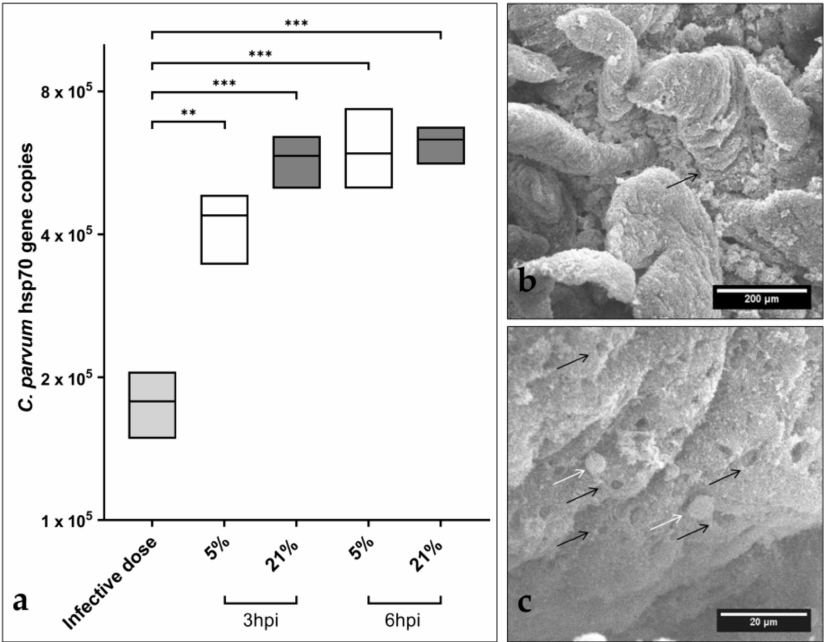
Figure 1. Early Cryptosporidium parvum development in bovine small intestinal (BSI) explants under both physioxic (5% O 2 ) and hyperoxic (21% O 2 ) conditions. A significant increase in parasite replication was detected in BSI explants ( n = 3) via C. parvum hsp 70 gene-specific qPCR analyses, and by comparing 3 and 6 hpi with the initial sporozoite infection dose (i.d.), boxplots represent mean ± SD ( a ). SEM analysis of BSI explants confirmed parasite replication by revealing C. parvum - infected villi (black arrow) ( b ). Interestingly, C. parvum -infected BSI explants presented typical C. parvum -induced hole-like lesions in epithelial cells (black arrows), along with development of trophozoite-like stages (white arrows), which were detected as early as 3 hpi ( c ). Statistical significance (** p < 0.01, *** p < 0.001) was determined by Kruskal–Wallis test followed by Dunn’s multiple comparison test comparing infected BSI explants with initial sporozoite numbers used for infection (infection doses, n = 3). qPCR- and SEM-based analyses were performed in duplicate and triplicate,